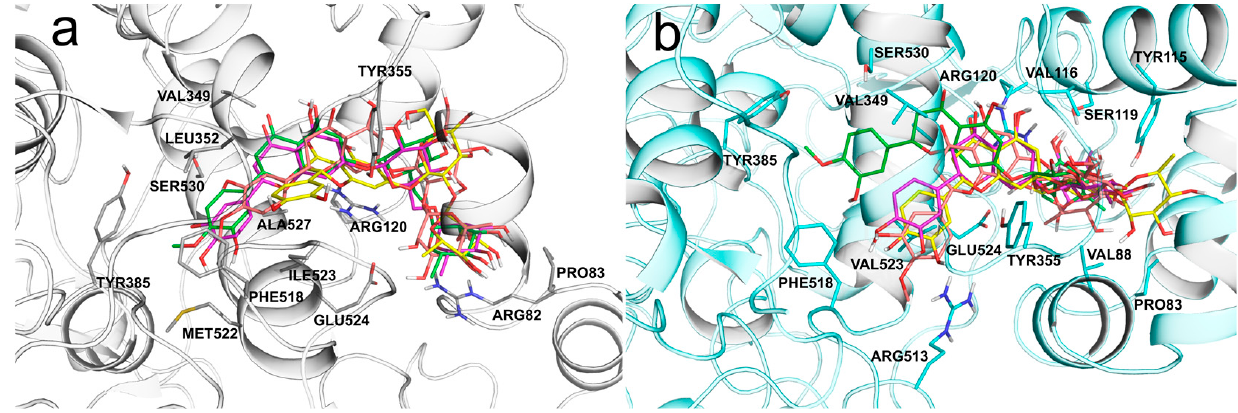
Figure 1. Docking poses of HED (green sticks), ERI (magenta sticks), NHE (orange sticks), and NER (yellow sticks) into ( a ) COX-1 (gray cartoons and sticks) and ( b ) COX-2 (cyan cartoons and sticks).